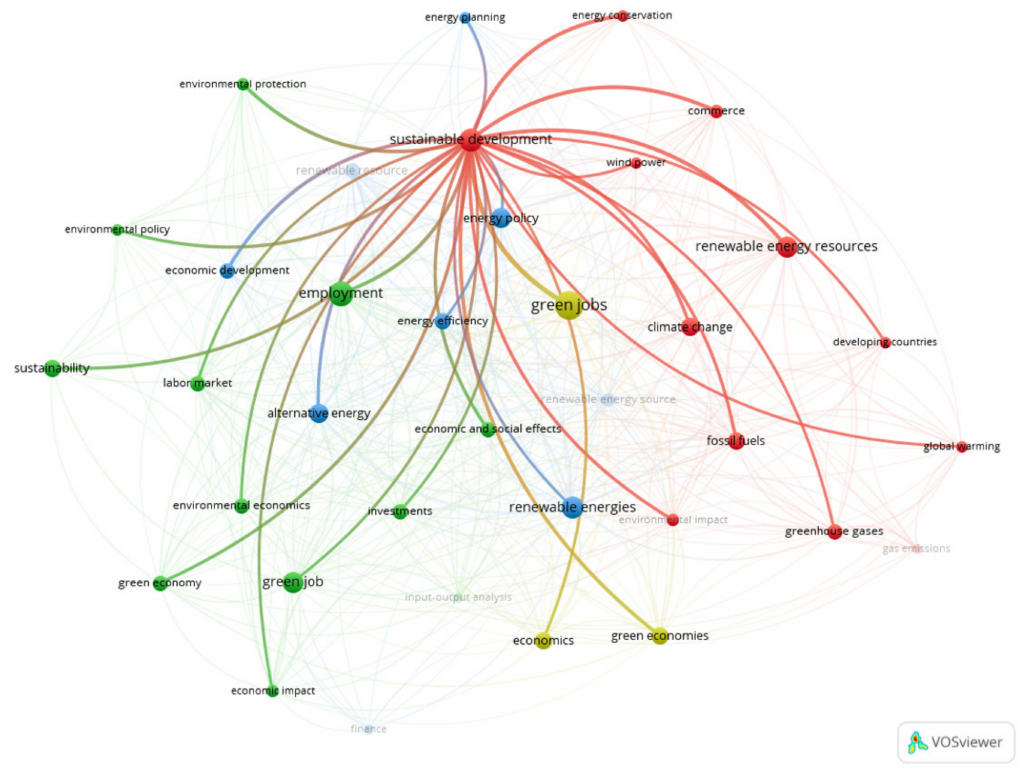
Figure 11. Keyword “sustainable development” relations with other keywords. Source: Authors’ elaboration in VOSviewer software (1.6.18